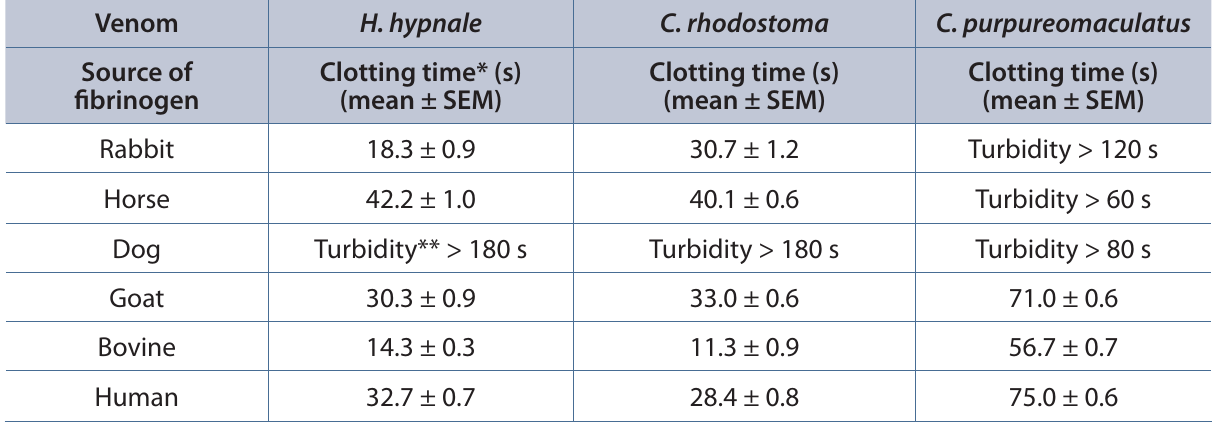
Table 3. Procoagulant effects of venoms from three pit vipers on mammalian fibrinogens